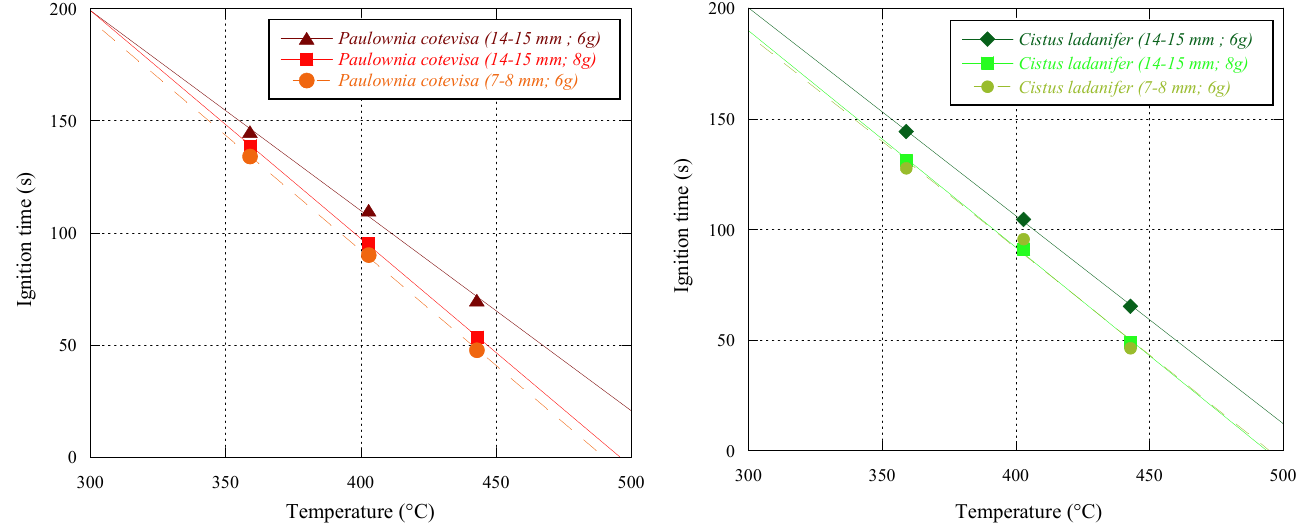
Figure 8. Ignition time of Paulownia cotevisa and Cistus ladanifer as a function of furnace temperature and batch size and mass.